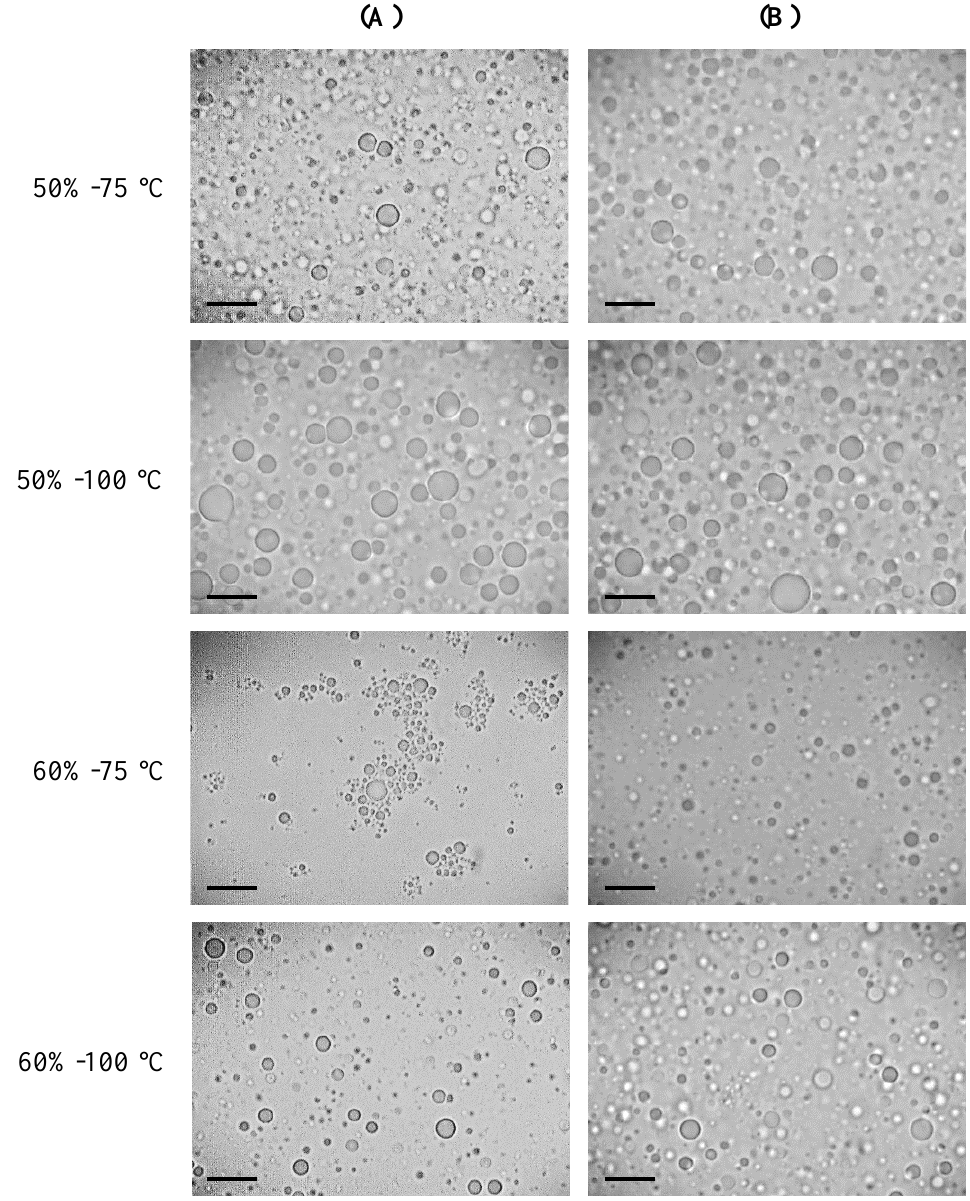
Figure 4. Micrographs (100 × ) of IMF powder emulsions, reconstituted in water ( A ) and 1% SDS ( B ). Black bars represent 50 µ